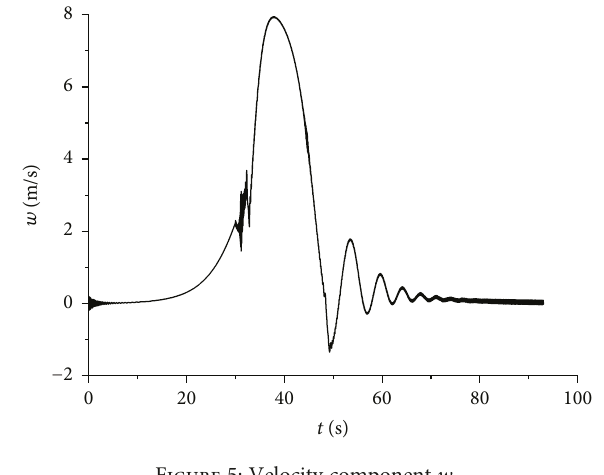
Figure 5: Velocity component w .